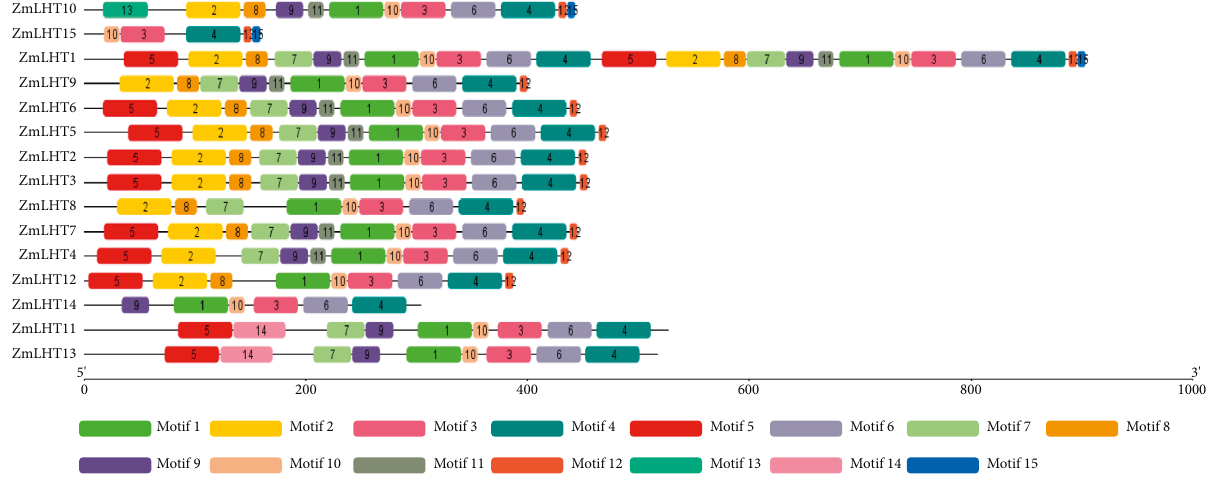
Figure 3: Analysis of conserved motif of LHT gene family in